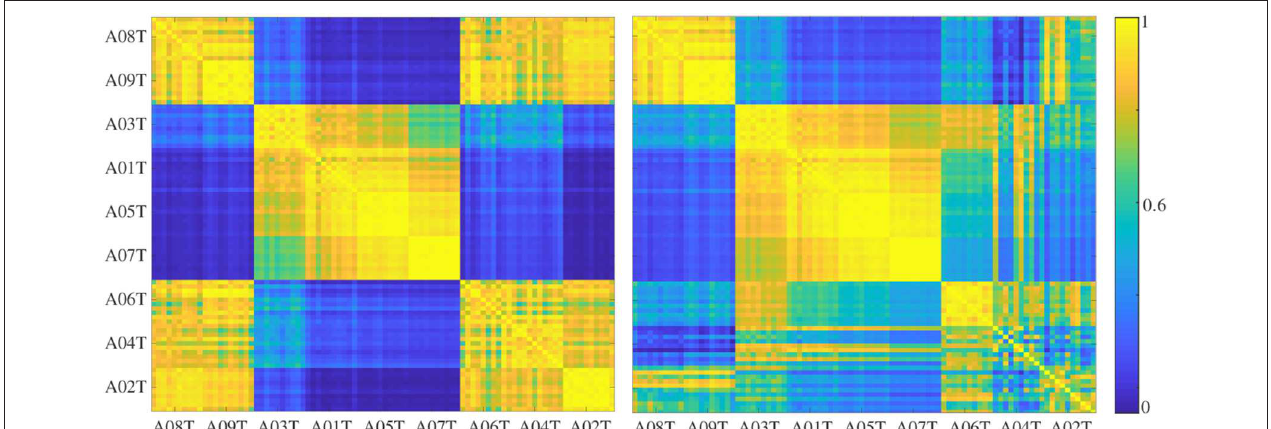
FIGURE 5 | Pairwise similarity between subjects across the trial set assessed when omitting the optimization of t-f atoms (Left) and using the Multiple-Instance Logistic Regression (Right) .